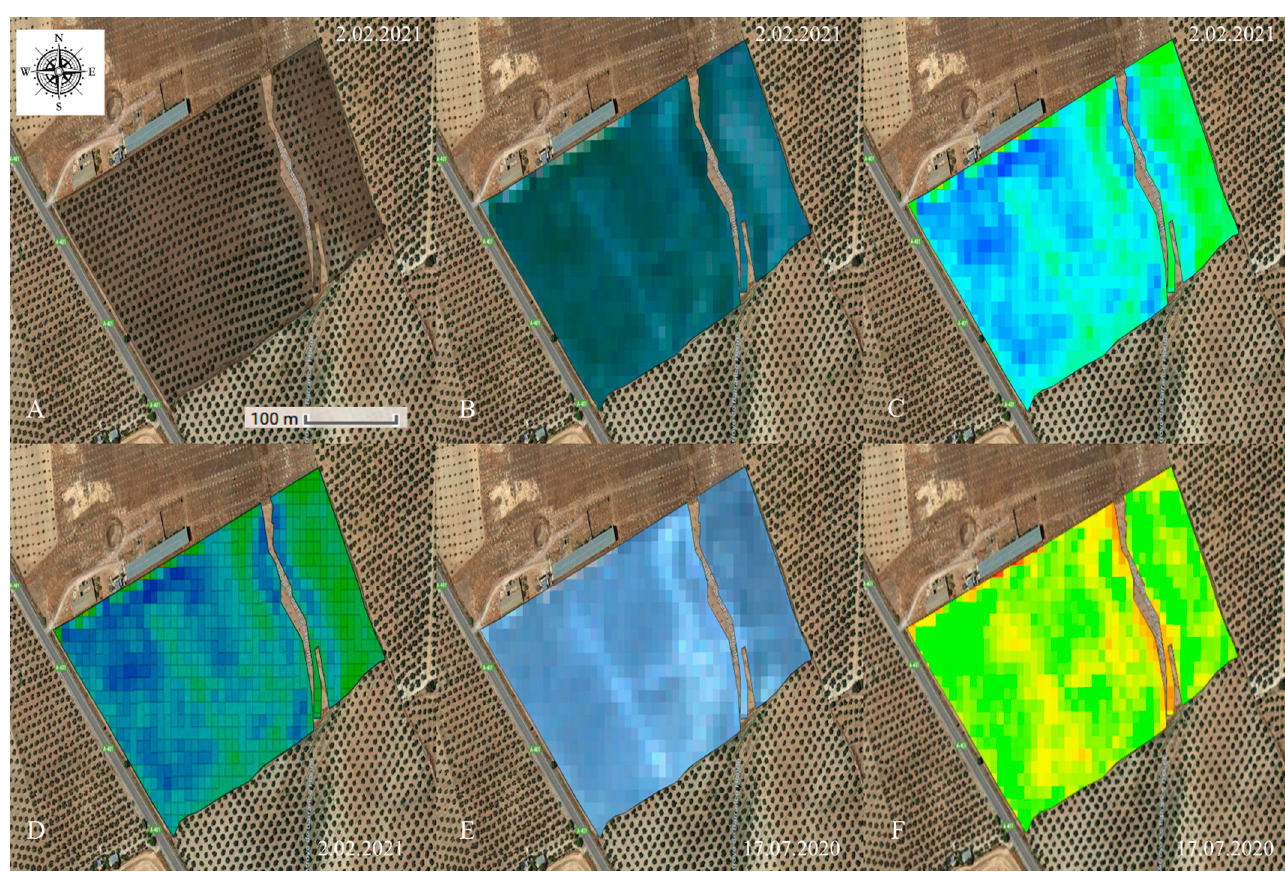
Figure 3. Sentinel-2 images accessed through Google Earth Engine (GEE). ( A ) Area of interest, ( B ) RGB field composition, ( C ) NDVI raster tile, ( D ) NDVI vector tile, ( E ) RGB field composition, ( F ) NDVI raster tile (Images facilitated by Graniot).